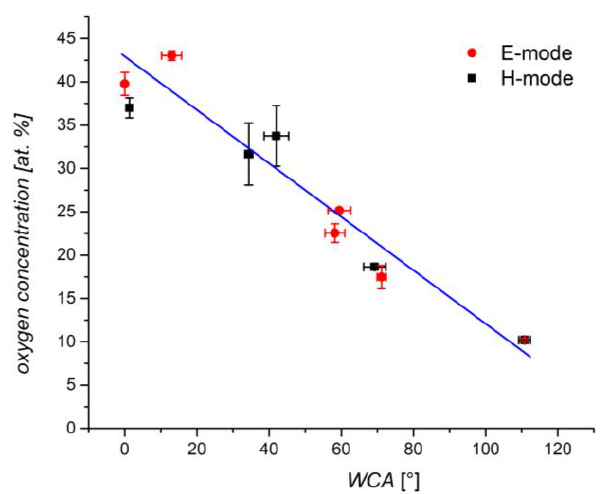
Figure 8. The oxygen concentration versus the water contact angle after treatment in E and H-mode’s plasma. The error bars represent standard error. Mean values ( ± SE) for the respective triplicates of WCA are given.